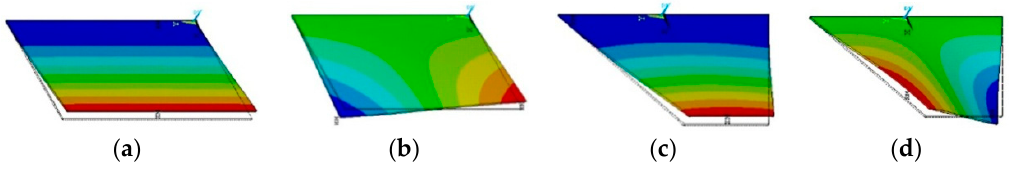
Figure 3. Vibration shapes of two micro-cantilevers in deflection under the first two order modes.